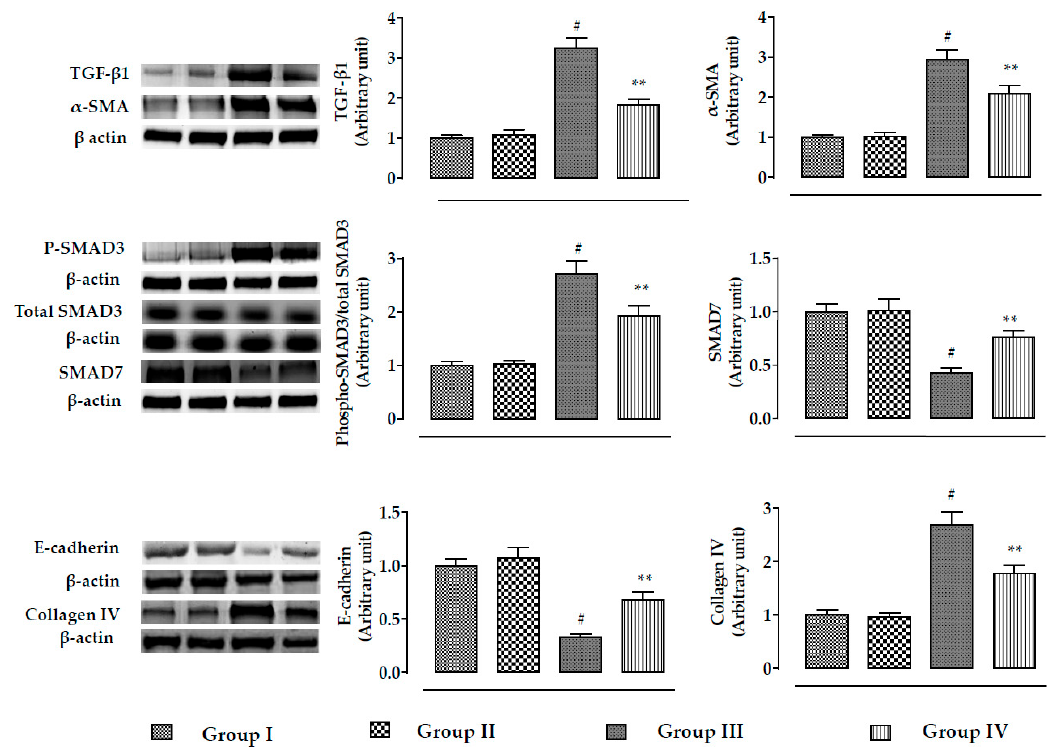
Figure 6. The effects on TGF- β 1, α -SMA, SMAD3 SMAD7, E-cadherin, and collagen-IV expressions in the absence (CdCl 2 ) and presence of RA (CdCl 2 + RA) in vitro on mouse proximal tubular epithelial cells. The relative band intensities were assessed, and the intensity of the normal control band was assigned as 1. β -Actin served as the loading control. Data are represented as means ± SD, n = 3 (number of plates). # Values significantly ( p < 0.01) differ from normal control. *Values significantly ( p < 0.05) differ from CdCl 2 control. ** Values significantly ( p < 0.01) differ from CdCl 2 control. Group I: